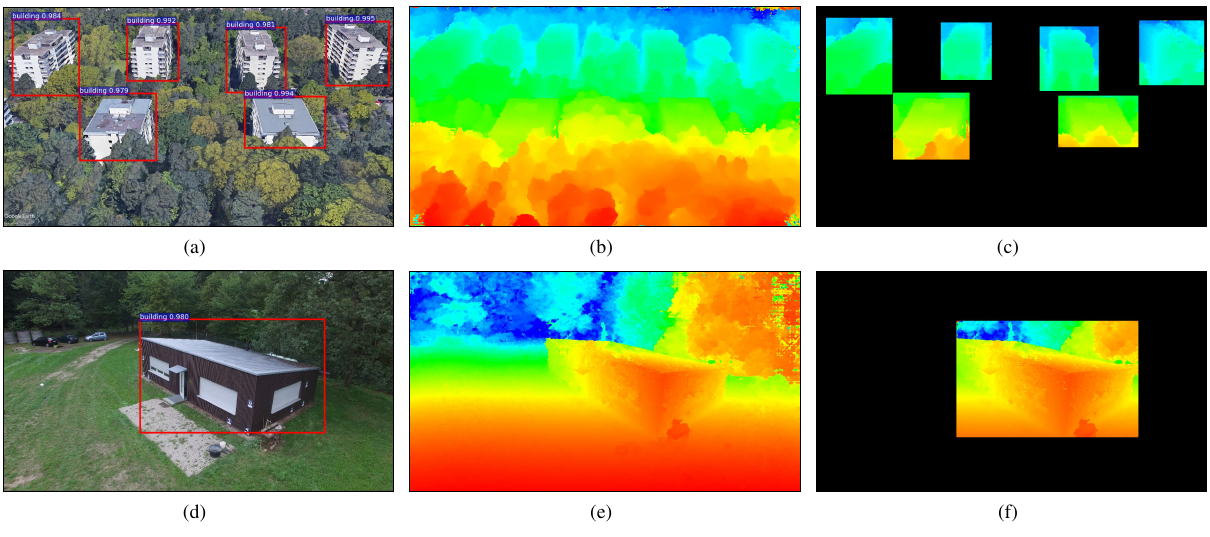
Figure 6. Results of selective image-based depth estimation. Figures (a) and (d) show the reference frames with corresponding detections. Figure (a) was captured at a distance of 150m with an off-nadir angle of 60 ◦ . Figure (d) was captured at an altitude of 15m. Full depth maps corresponding to the reference frames are shown in Figures (b) and (e). The results of a selective image-based depth estimation are shown in Figures (c) and (f), where the depth is only computed for the detected objects. Depth values are color-coded going from red (near) to blue